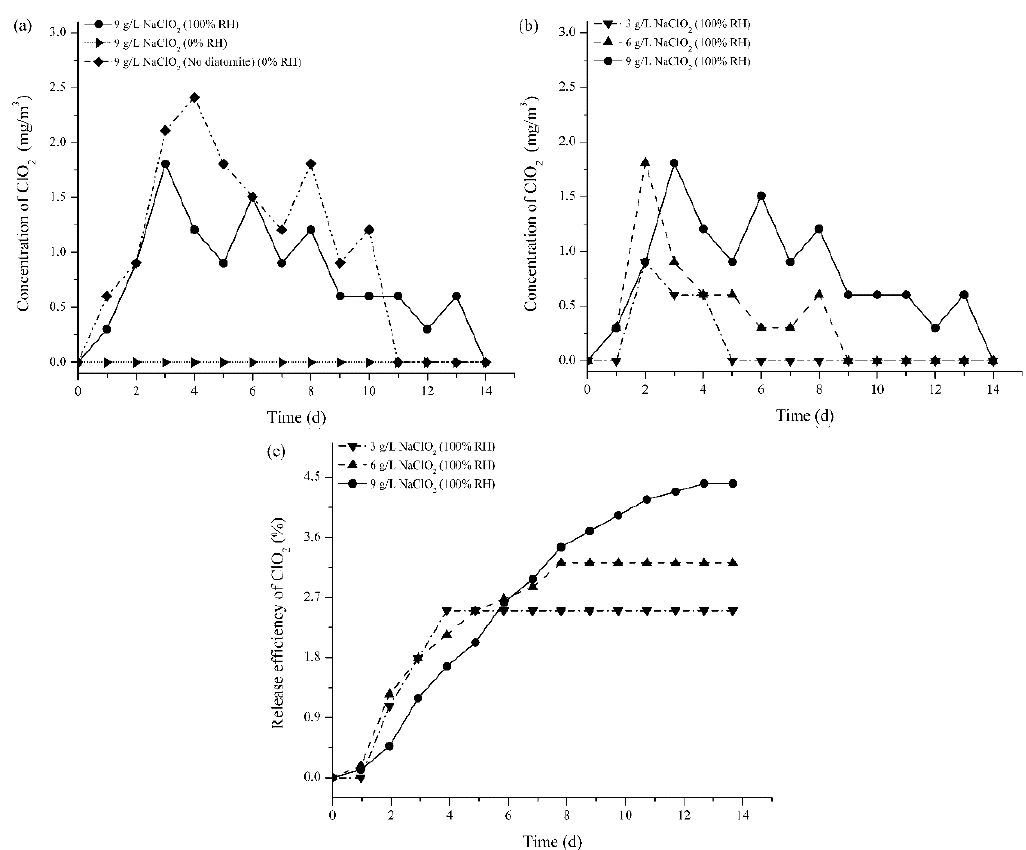
Figure 1. The release behaviors of ClO 2 from the coated corrugated cardboards: ( a ) effects of relative humidity and diatomite on the release rate; ( b ) effects of NaClO 2 concentration on the release rate; ( c ) effects of NaClO 2 concentration on the release efficiency.